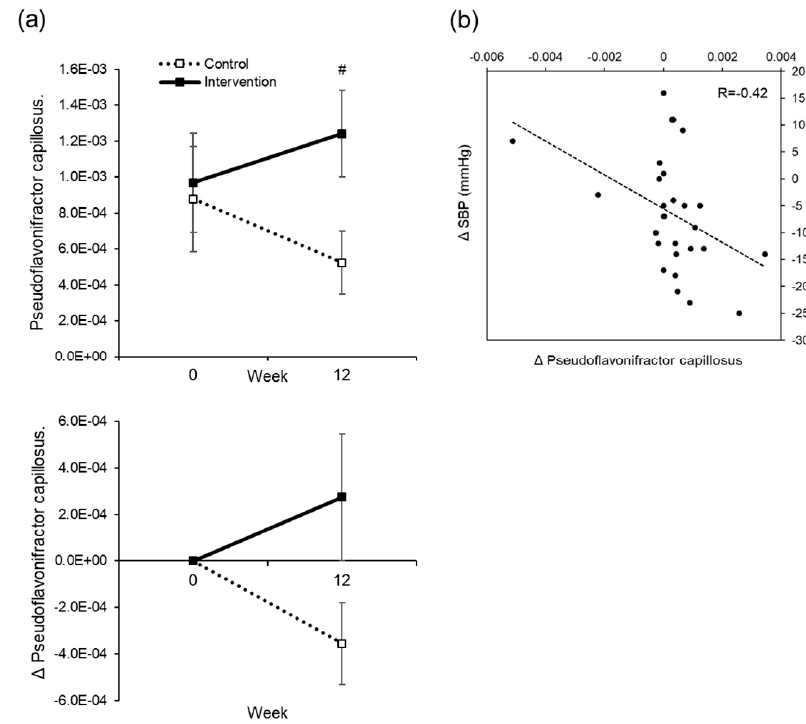
Figure 7. Correlation between the change in systolic blood pressure (SBP) and changes in intestinal bacteria. The actual level (upper) and changes (lower) in the OTU of Psudoflavoniflactor capillosus. The dotted line is the control group. The solid line is the intervention group. Mean ± SEM ( a ). # t -test of two independent samples, for comparison between groups at each time point, # p < 0.05. A correlation diagram between the changes in OTU of Psudoflavoniflactor capillosus, and changes in SBP between Weeks 0 and 12, in the intervention group ( b ). R = Correlation coe ffi